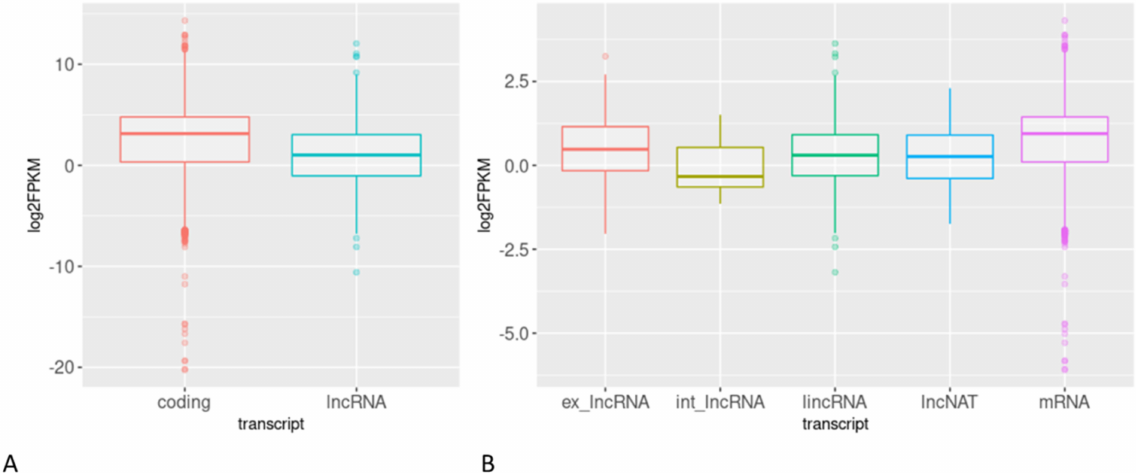
Figure 3. Expression levels of lncRNA and protein-coding gene transcripts. ( A ) Comparison of the FPKM values of all lncRNAs and coding transcripts; ( B ) comparison of the FPKM levels of exonic (ex-lncRNA), intronic (int_lncRNA), long intergenic (lincRNA) and antisense (lncNAT) lncRNA transcripts with mRNA